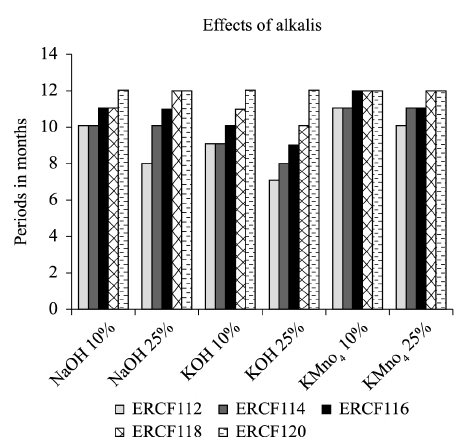
Figure 5. Graph of effects of alkalis in epoxidized resole